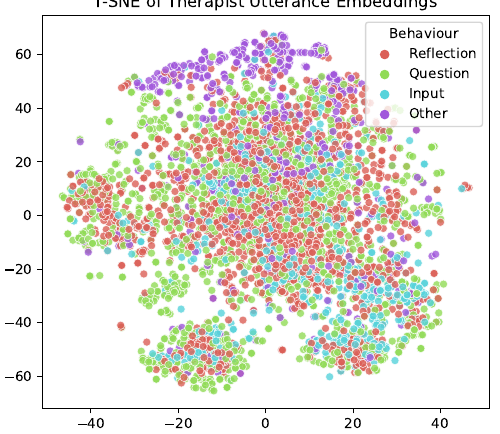
Figure 10. t-SNE of therapist utterance embeddings.